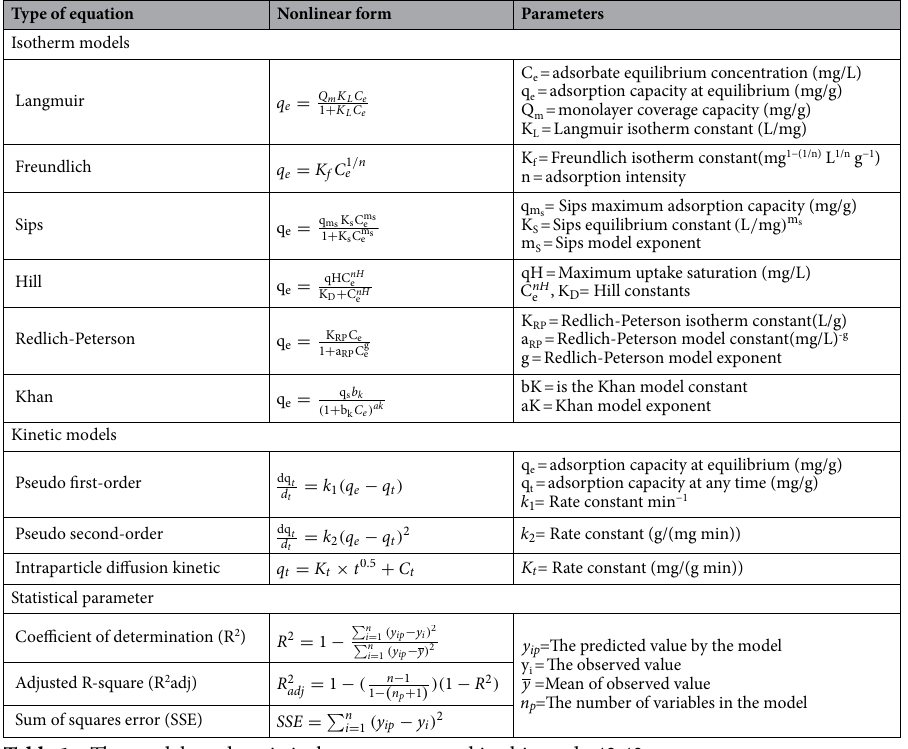
Table 1. The models and statistical parameters used in this study 42,43.